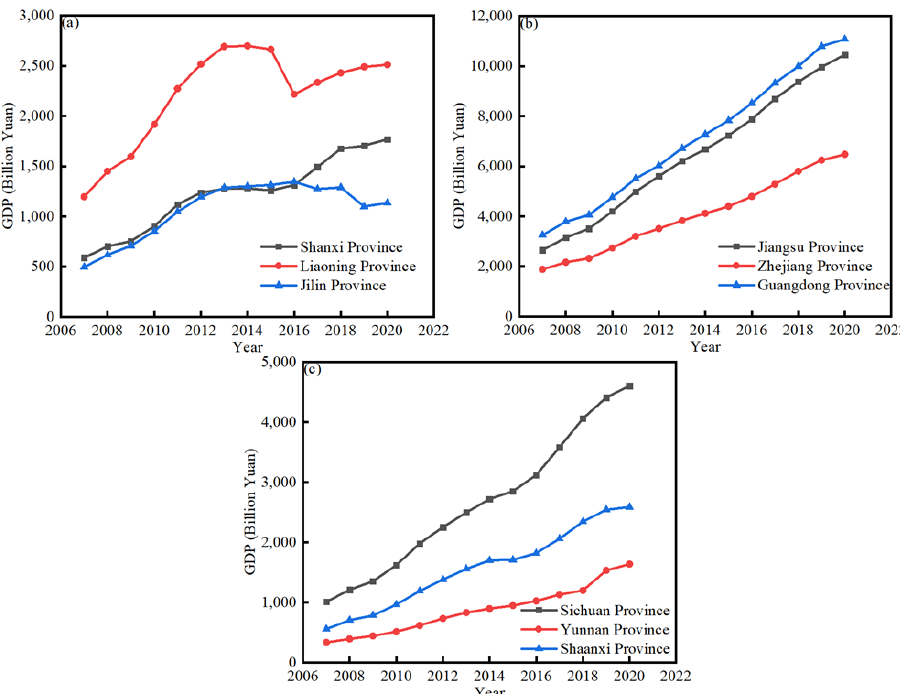
Figure 2. ( a ) Shanxi, Liaoning, Jilin and Provinces; ( b ) Jiangsu, Zhejiang, Guangdong and Provinces; ( c ) Sichuan, Yunnan, and Shaanxi Provinces. Change in GDP over time (2006–2020) (Data: IBRD. IDA).